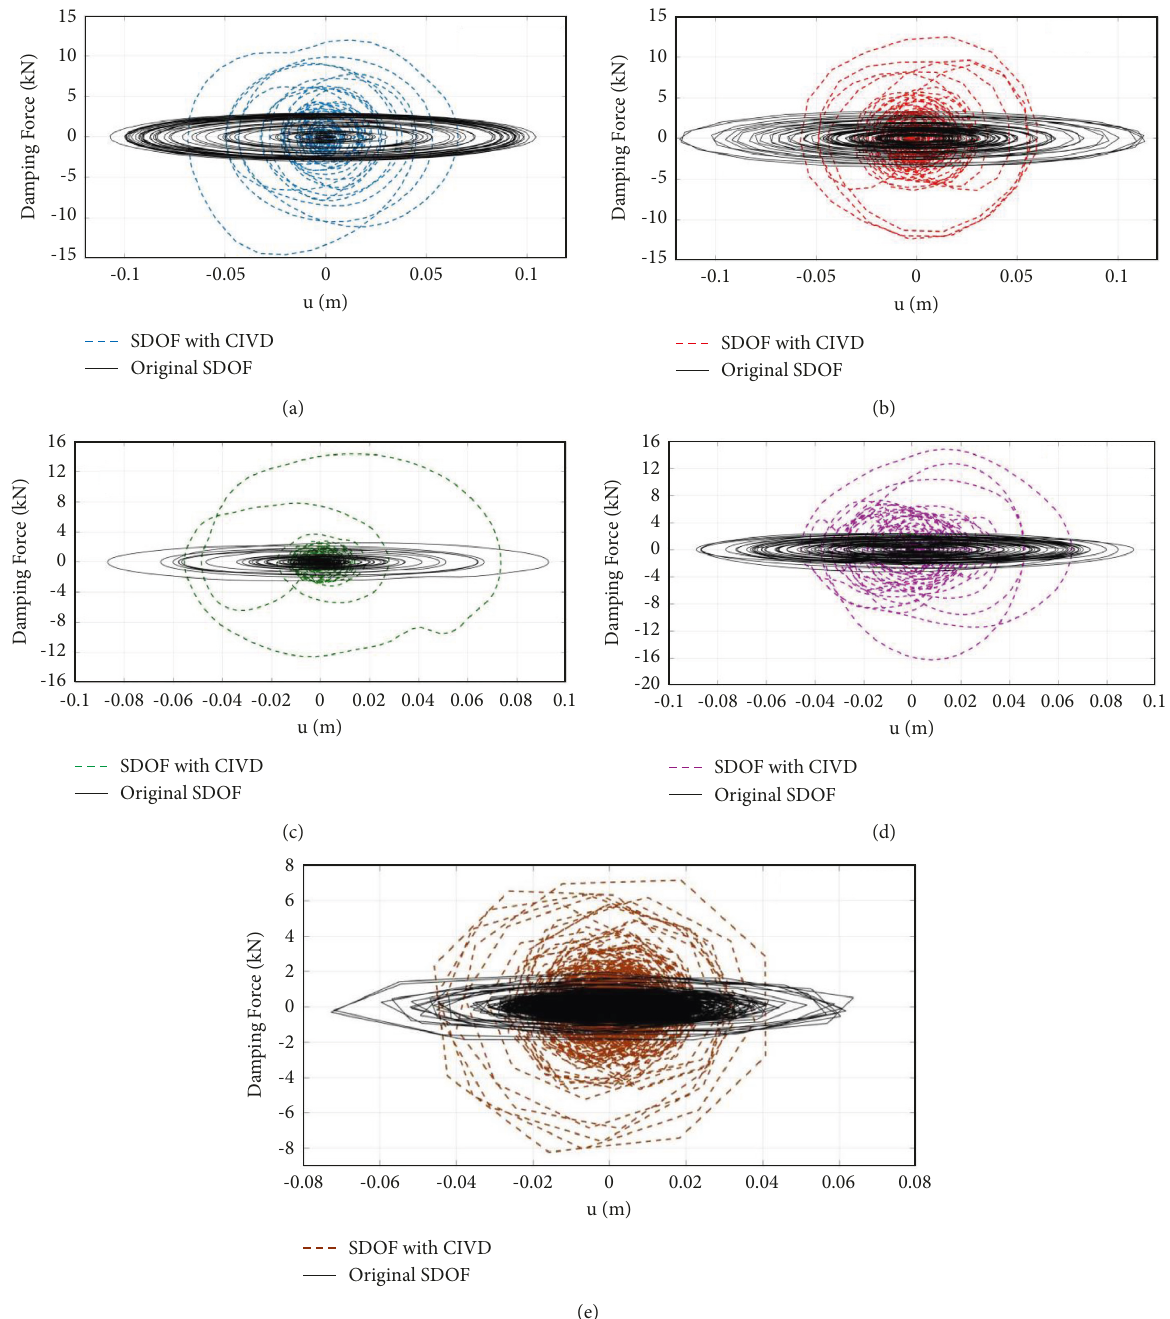
Figure 13: Damping force and displacement of main structure (u) curves of SDOF with and without CIVD under: (a) the El Centro record; (b) the Taft record; (c) the Chi-Chi record; (d) the Kobe record; (e) fluctuating wind.